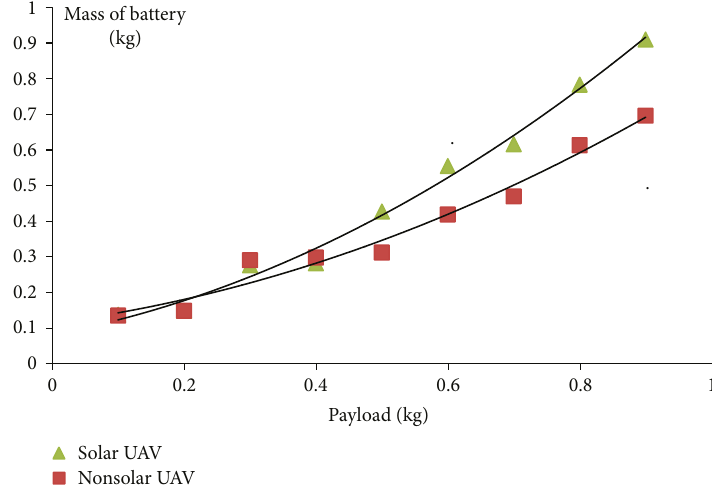
Figure 7: Mass of the payload versus battery of the solar and nonsolar UAVs.